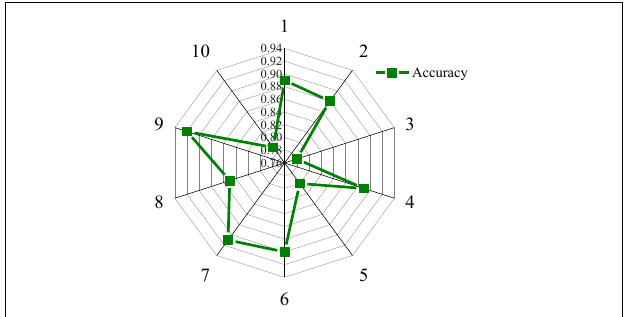
FIGURE 7 | Classification accuracy of 10 autistic children.